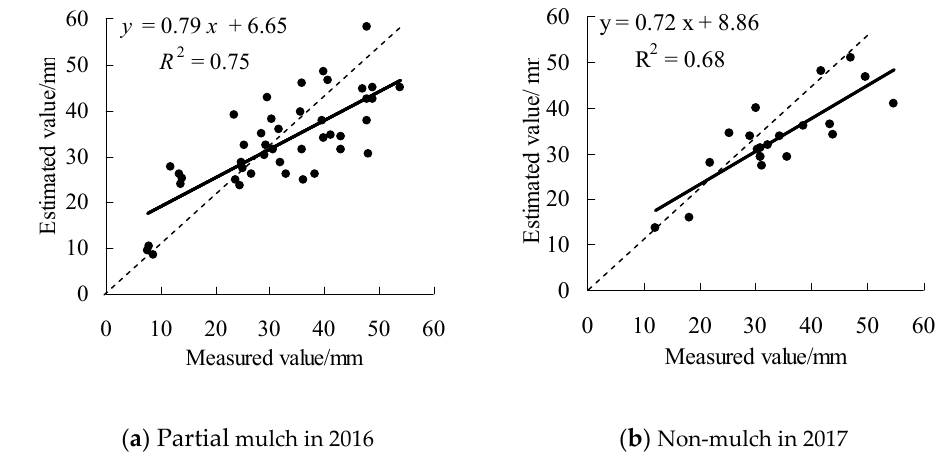
E ff ective area coe ffi cient of membrane hole α